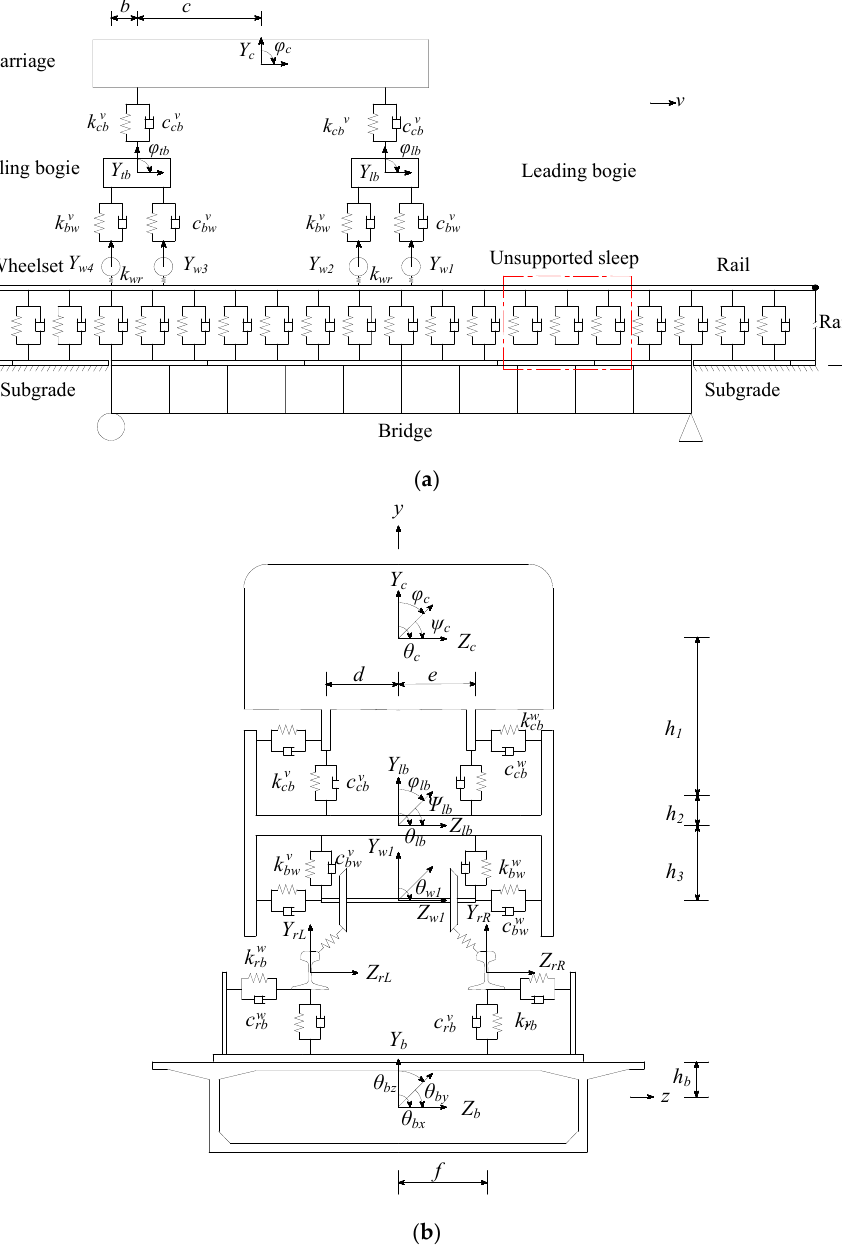
Figure 1. 3-D vehicle–track–bridge coupled model with the unsupported track: ( a ) front view and ( b ) lateral view.